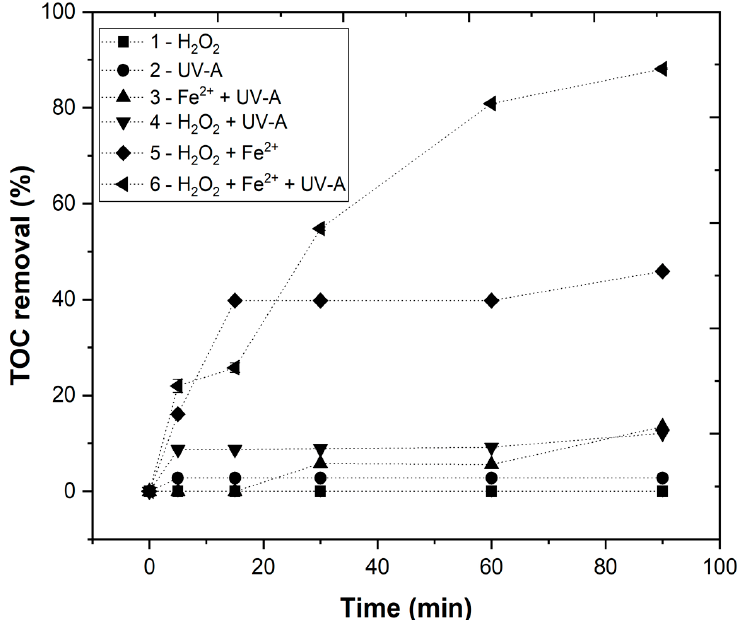
Figure 7. Chemical degradability of EW (TOC % removal) under different experimental conditions: [H 2 O 2 ] = 38.8 mM, [Fe 2+ ] = 1.0 mM, pH = 3.0, agitation = 350 rpm, T = 25 °C, radiation = UV-A, I UV = 32.7 Wm − 2 , t = 90 min.